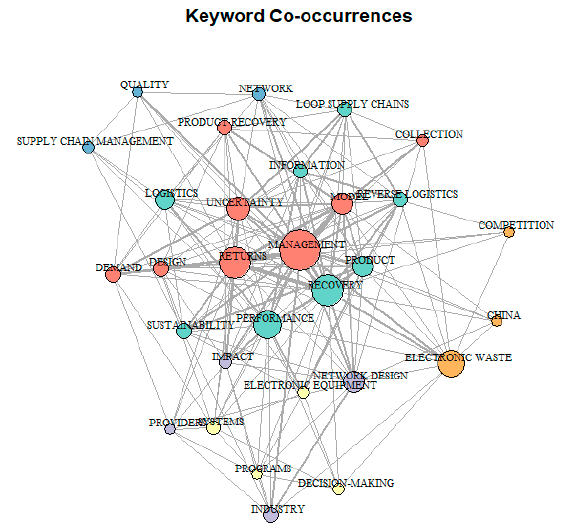
Figure 5. Co-occurrences of